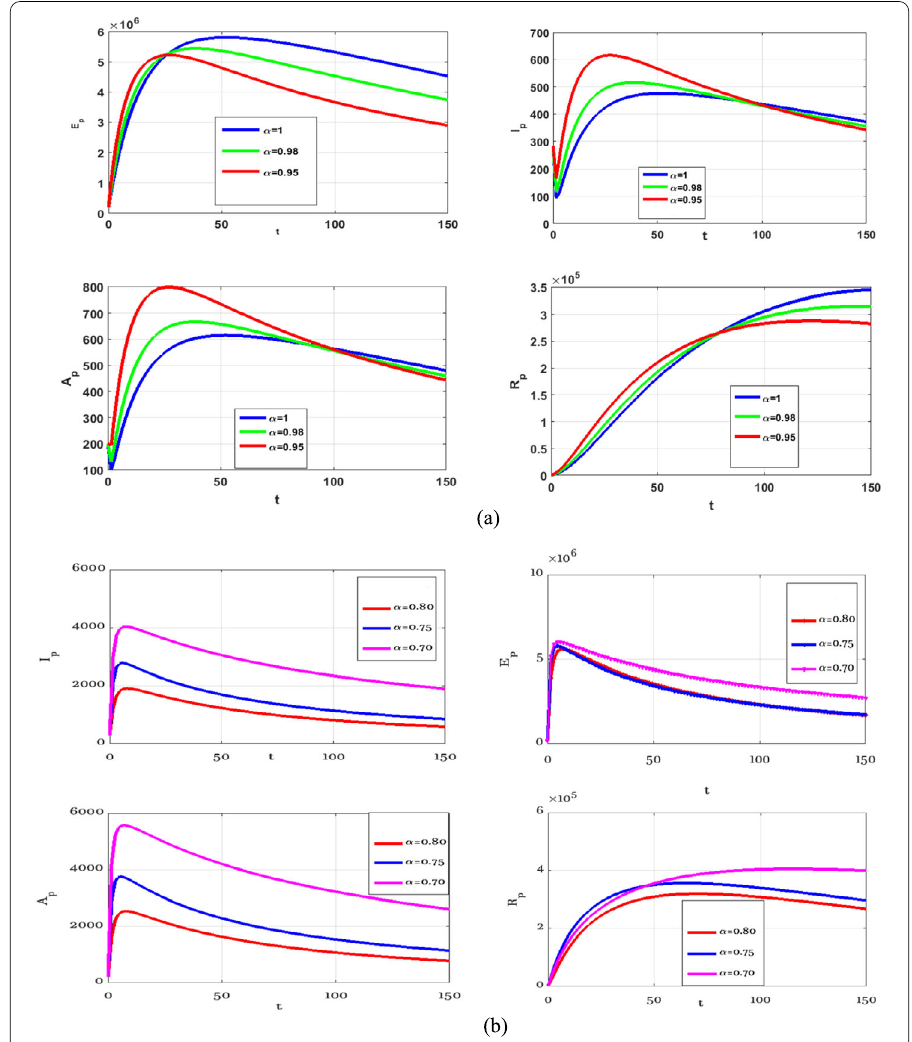
Figure 2 Numerical simulations at different α , (cid:21) = 1, B 1 = B 2 = 500, and (cid:12) 1 = (cid:12) 2 = 10 with two controls